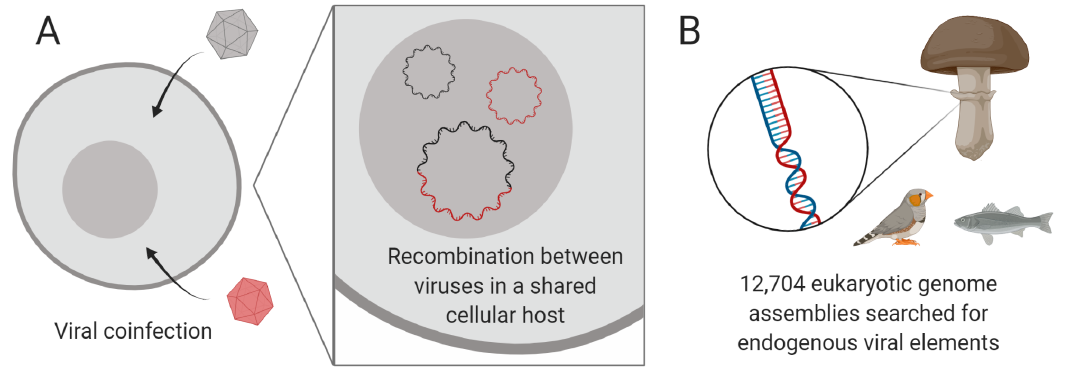
Figure 8. Identifying the hosts of metagenomic viruses in the Cressdnaviricota. ( A ) Recombination between single-stranded DNA viruses implies a shared cellular host, reducing the problem size from individual virus species to recombination networks. ( B ) Endogenous viral elements inside host genomes are used to anchor metagenomic viruses to specific host taxa. Created with